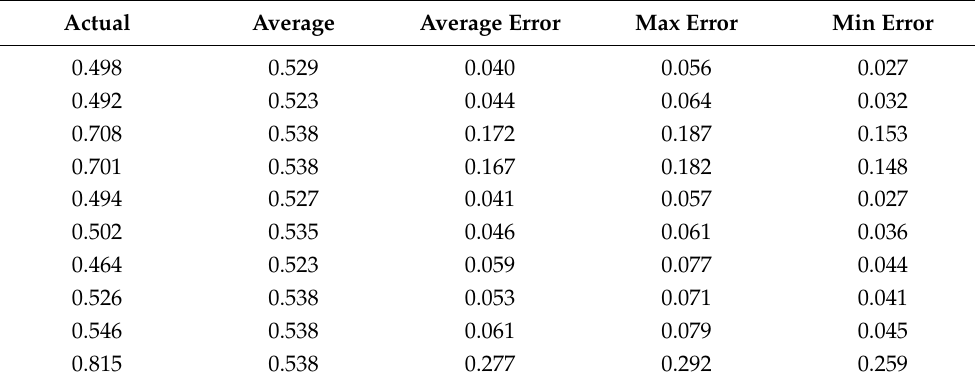
Table A4. Set 1, trials 1–10 data (average actual PR